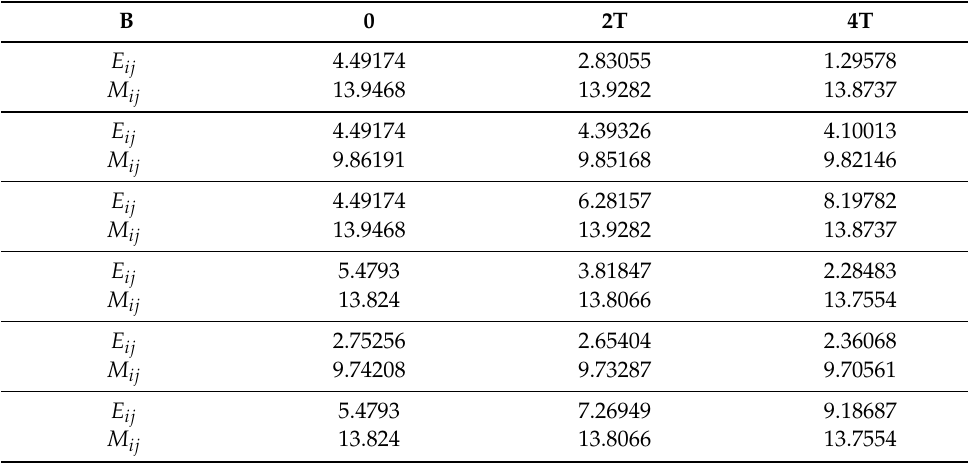
Table 1. The subband energy differences and dipole moment matrix elements for (a), (b), (c), (d), (e) and (f) respectively, in Figures 4 and